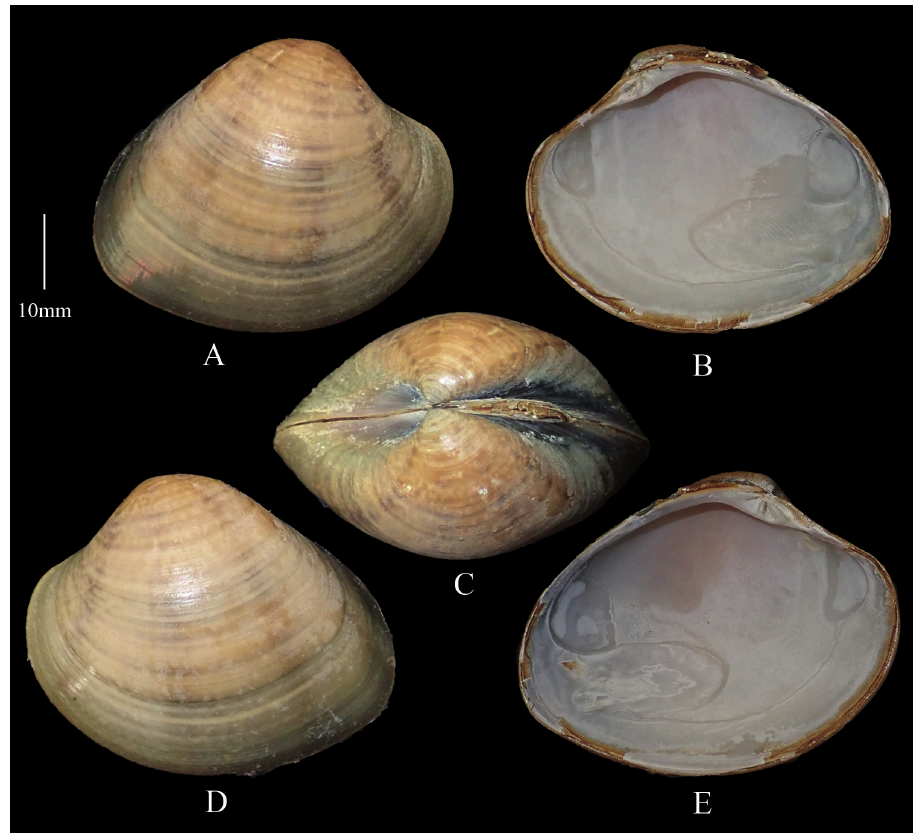
Figure 3. Marcia opima A right valve dorsal B right valve ventral C dorsal margin D left valve dorsal E left valve ventral (DABFUK), Ashtamudi,